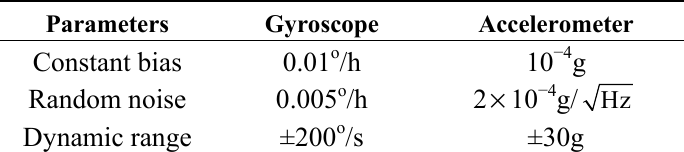
Table 1. Specifications of the IFOG based IMU.